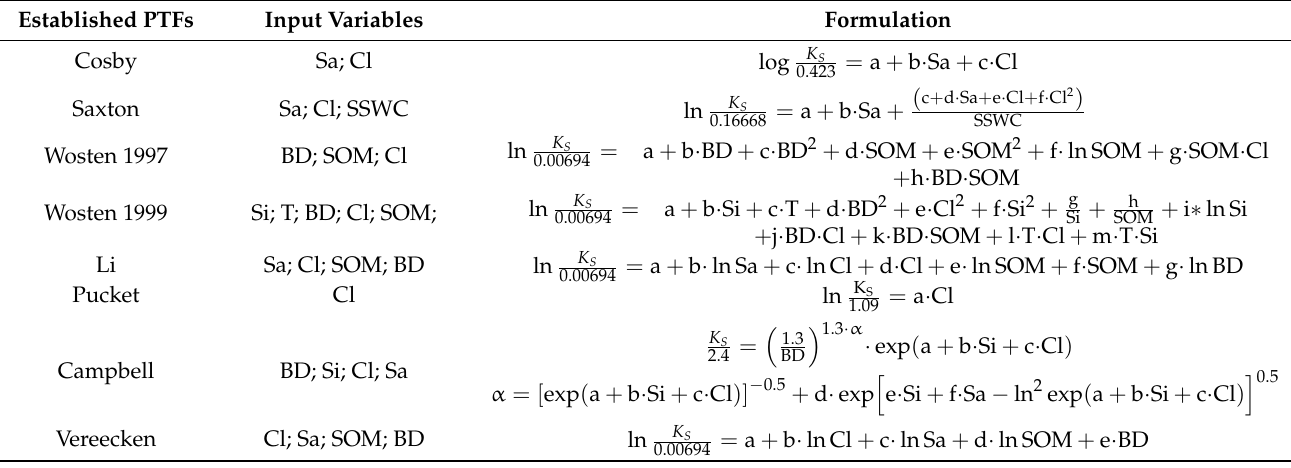
Table 3. Fundamental form of the PTFs modified in this study.